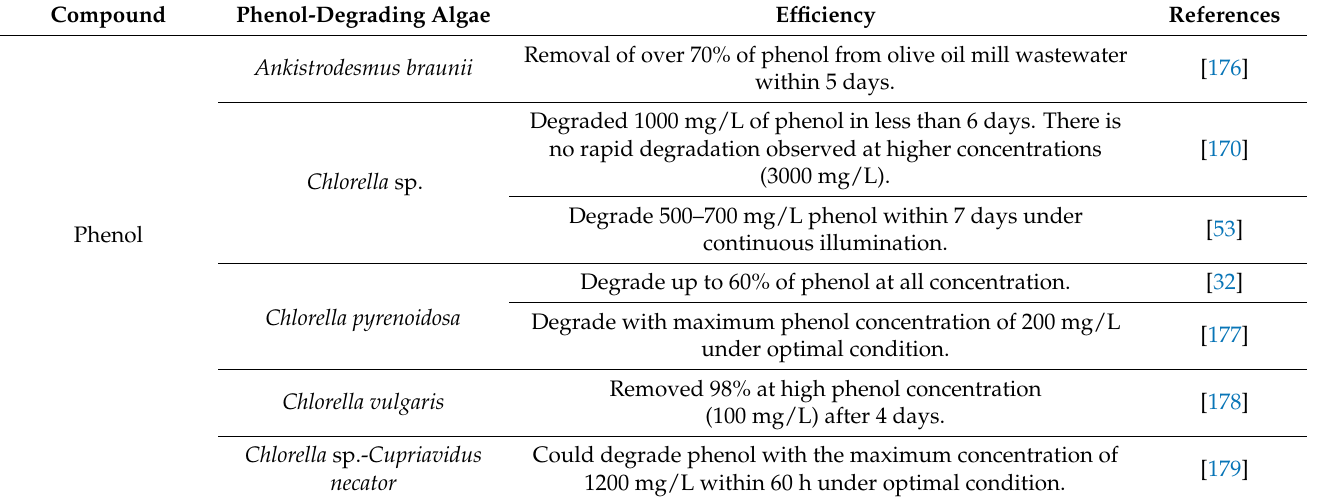
Table 12. The phenol-degrading